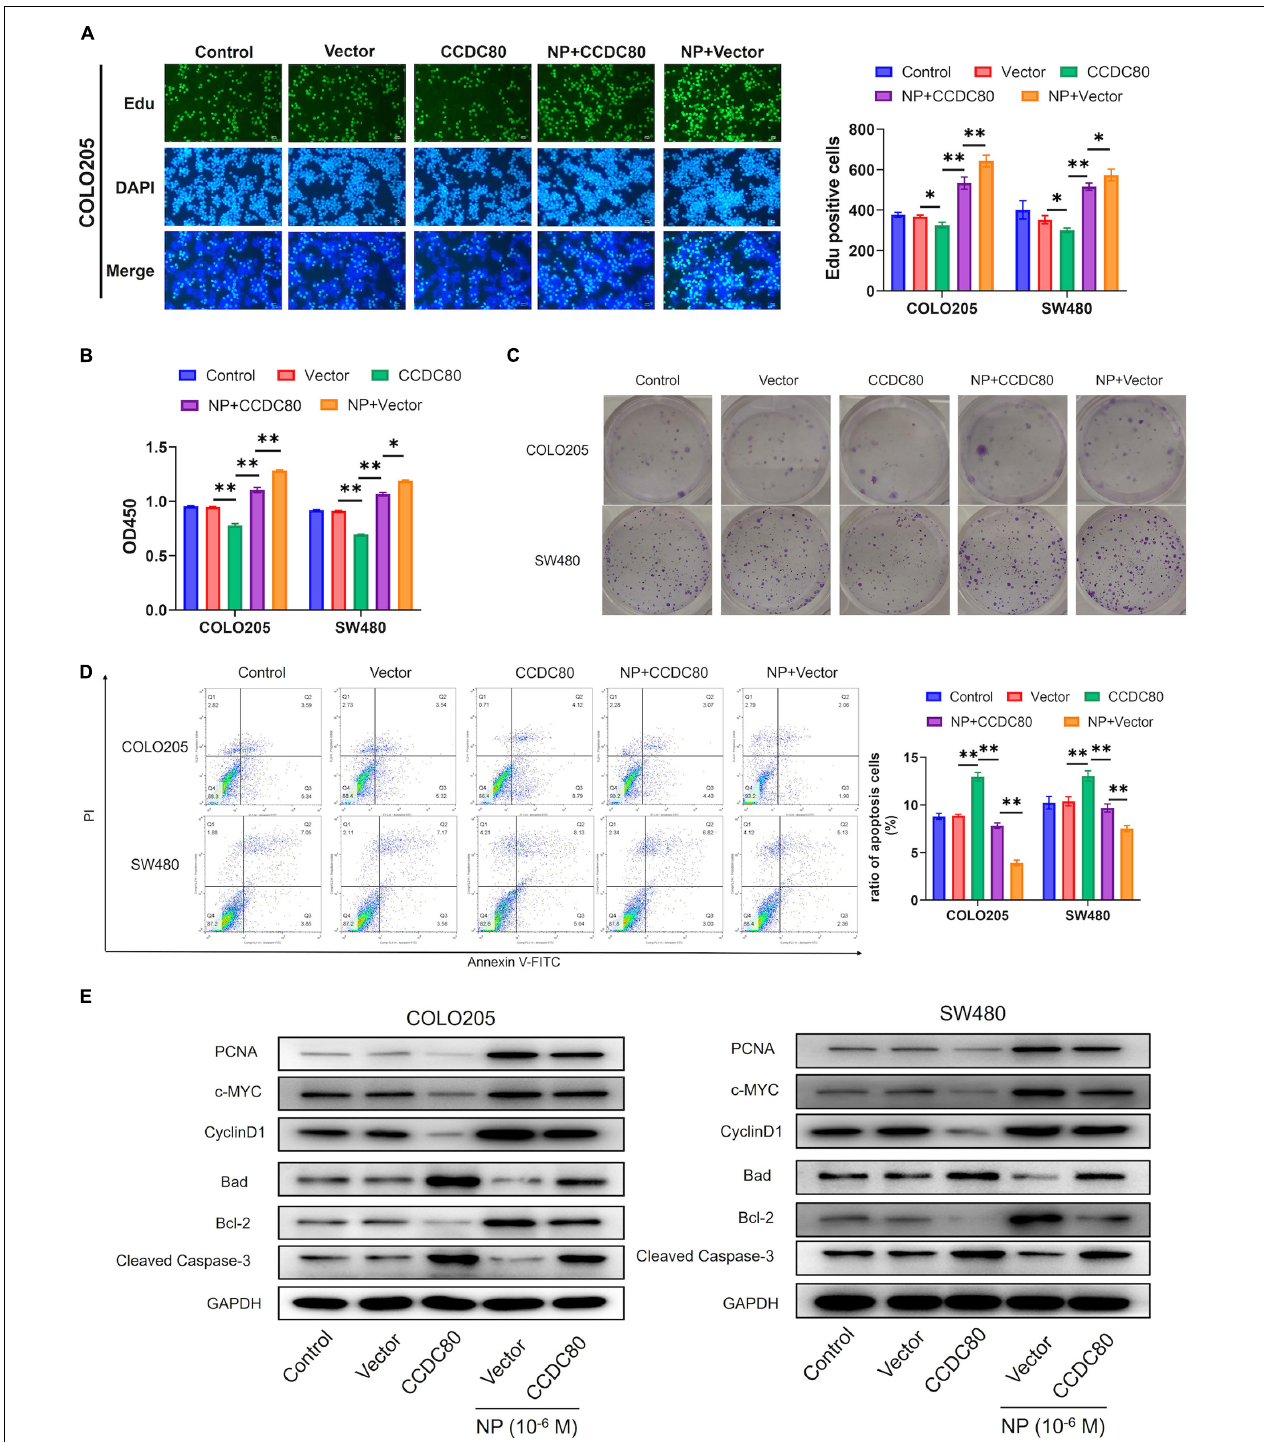
FIGURE 5 | Overexpression of coiled-coil domain containing 80 (CCDC80) suppresses nonylphenol (NP)-induced colorectal cancer (CRC) cell growth. (A) Infected COLO205 and SW480 cells treated with NP (10 − 6 M) for 24 h and tested using EdU assay. Bar = 100 µ m. Positive cells were measured, and the results are shown as bar charts. (B) The cell proliferation ability as tested using CCK8 assay in treated COLO205 and SW480 cells. (C) Colony forming assay performed to test the growth of treated cells. (D) Cell apoptosis in treated cells analyzed using flow cytometry. (E) The expression of cell proliferation-related proteins [proliferating cell nuclear antigen (PCNA), c-MYC, and CyclinD1] and cell apoptosis-related proteins (Bcl-2, Bad, and Cleaved Caspase-3) in treated cells analyzed using western blot assay. ∗ p < 0.05, ∗∗ p < 0.01.